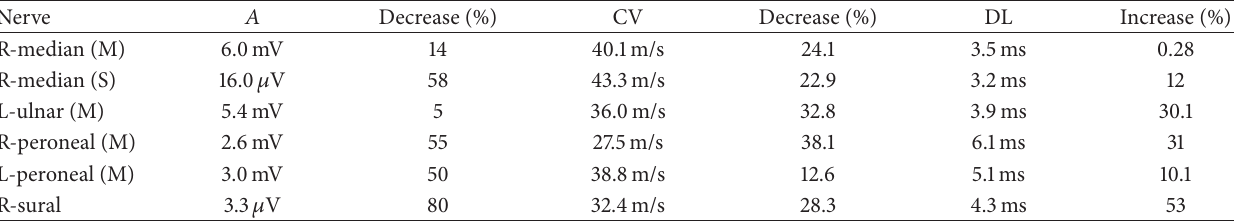
Table 1: Nerve conduction